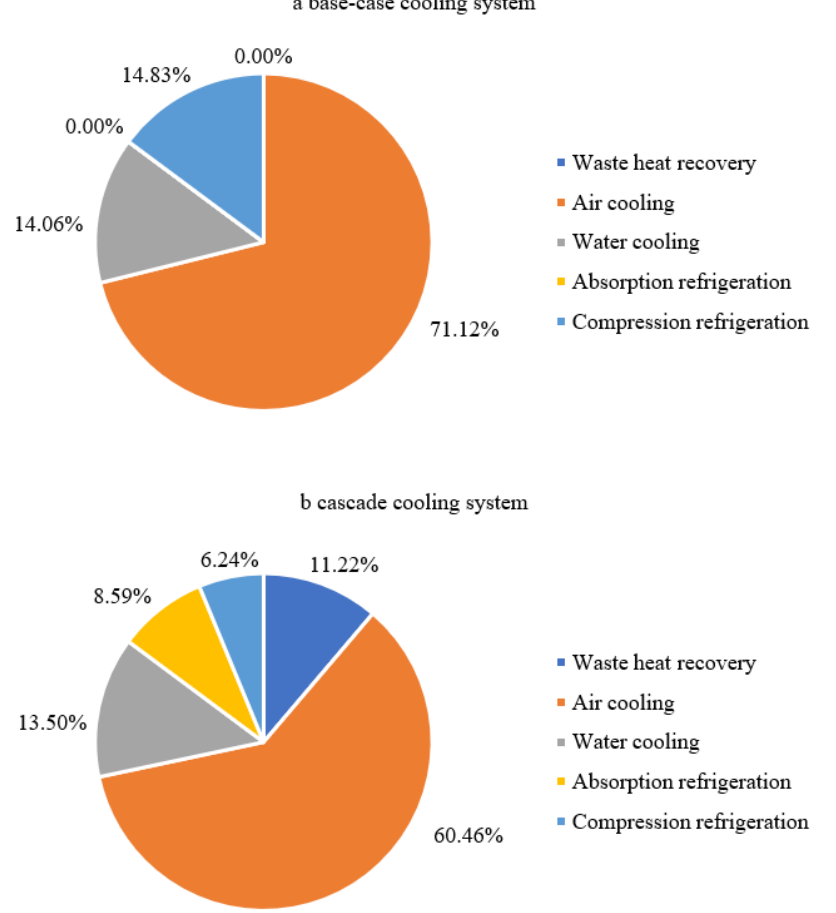
Figure 7. The heat load distribution of heat exchangers (hot stream H1). ( a ) base case cooling system; ( b ) cascade cooling system